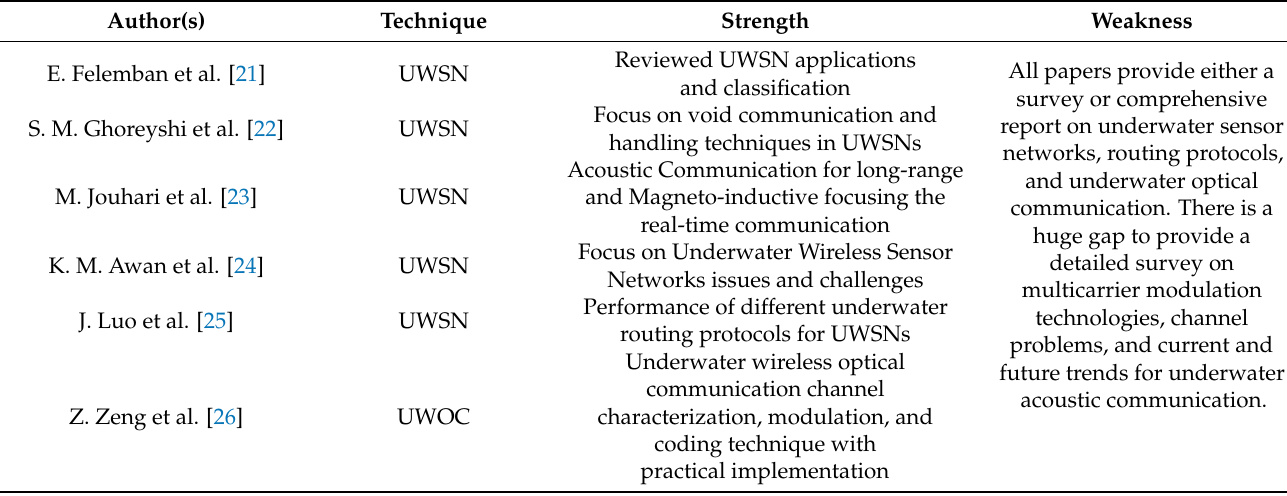
Table 2. Strengths and weaknesses of previous